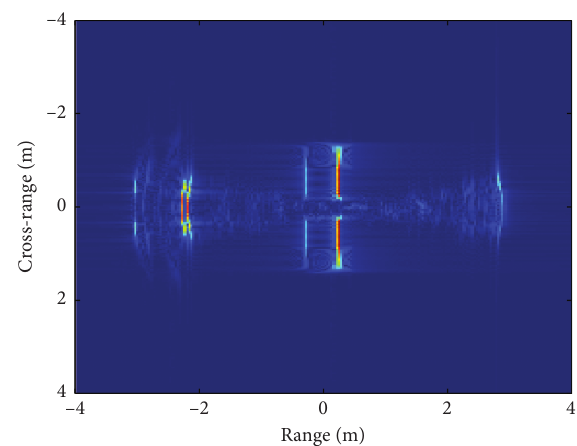
Figure 8: ISAR image with direct FFT for large-angle wide bandwidth.